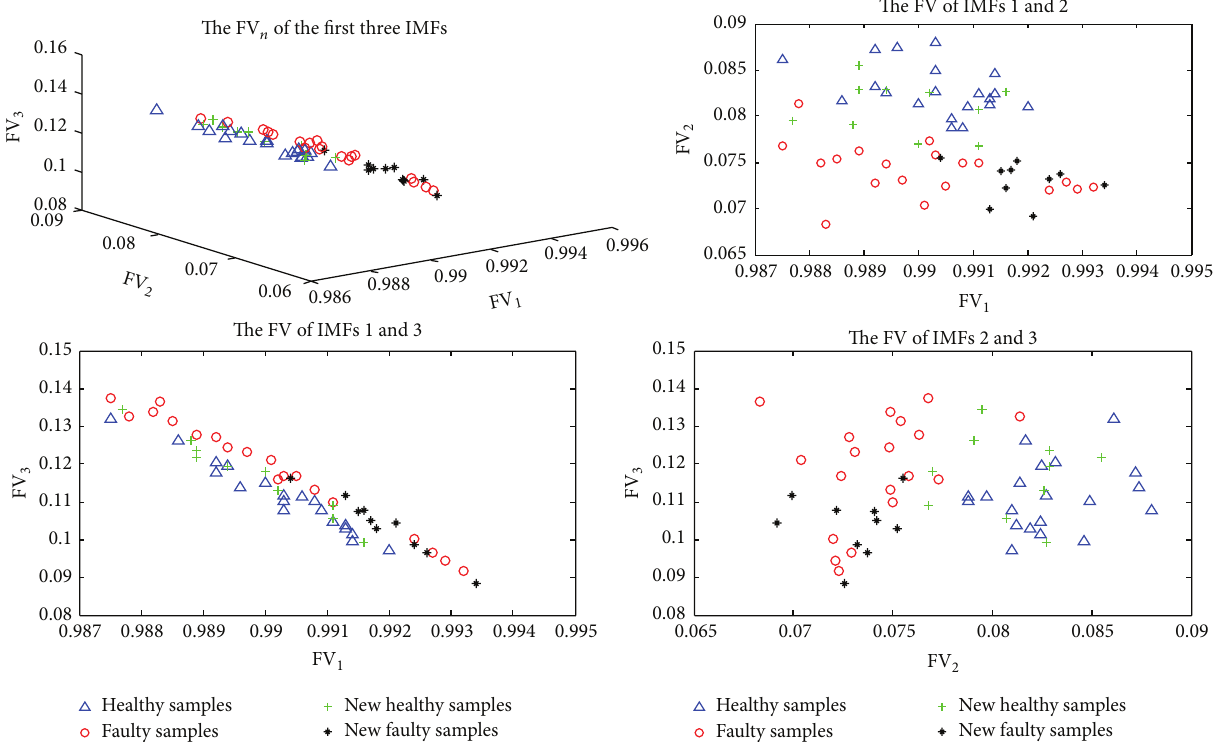
Figure 6: The normalized energy of the three first IMFs (FV 𝑛 ) with new samples, SNR = 20 (speed = 200 Hz and load = 1.8kN).